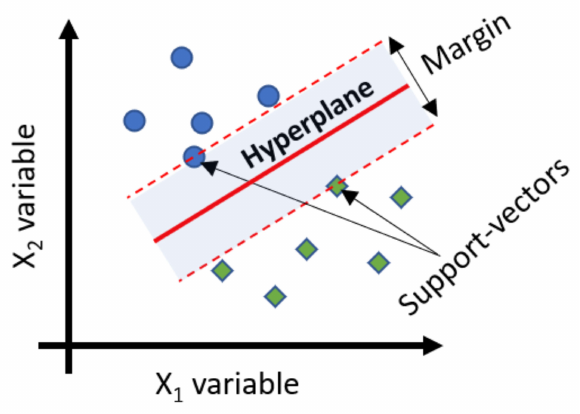
Figure 2. SVM, support vectors, hyperplane